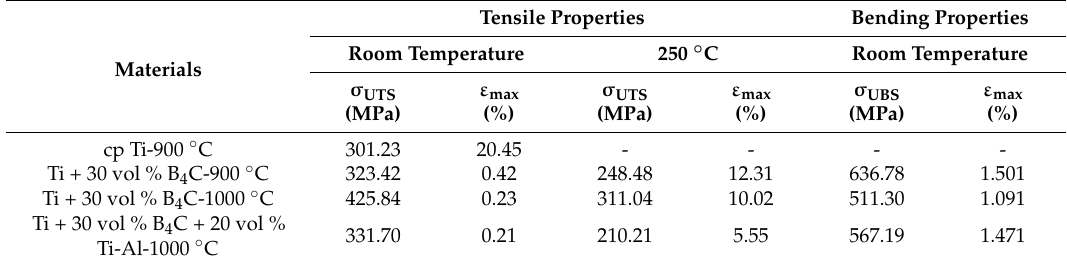
Table 3. Tensile properties measured at room temperature and 250 ◦ C and bending